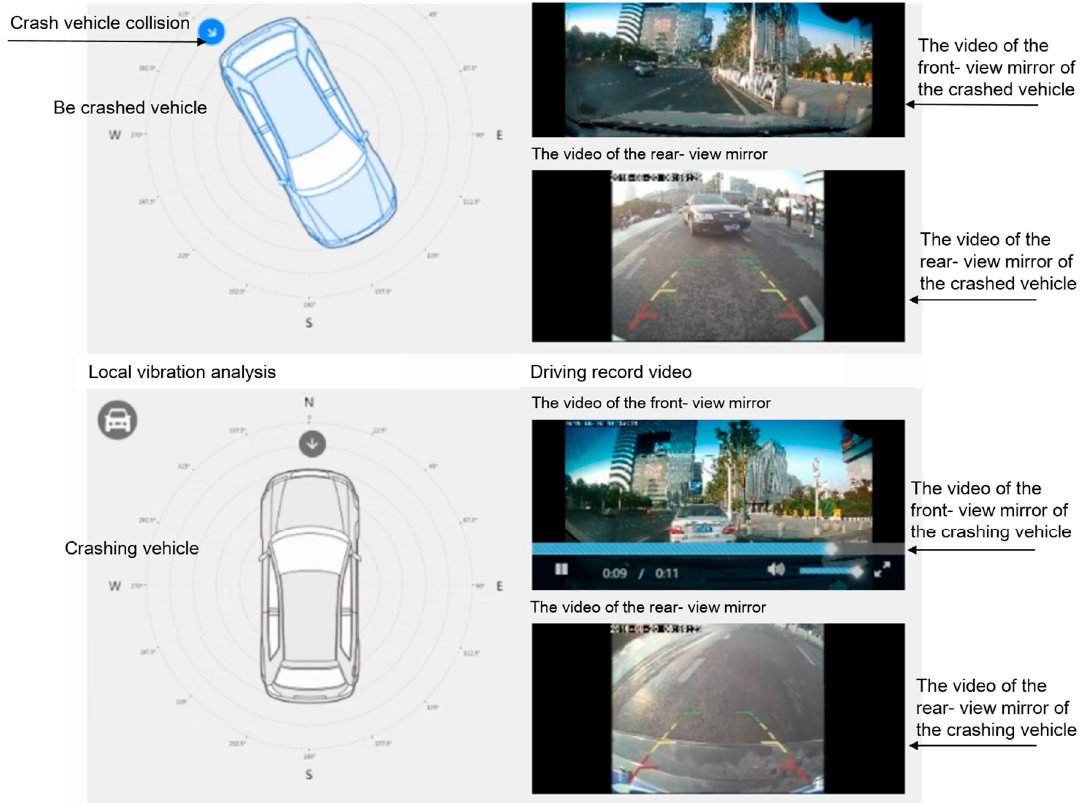
Figure 12. Views from the driving record video.